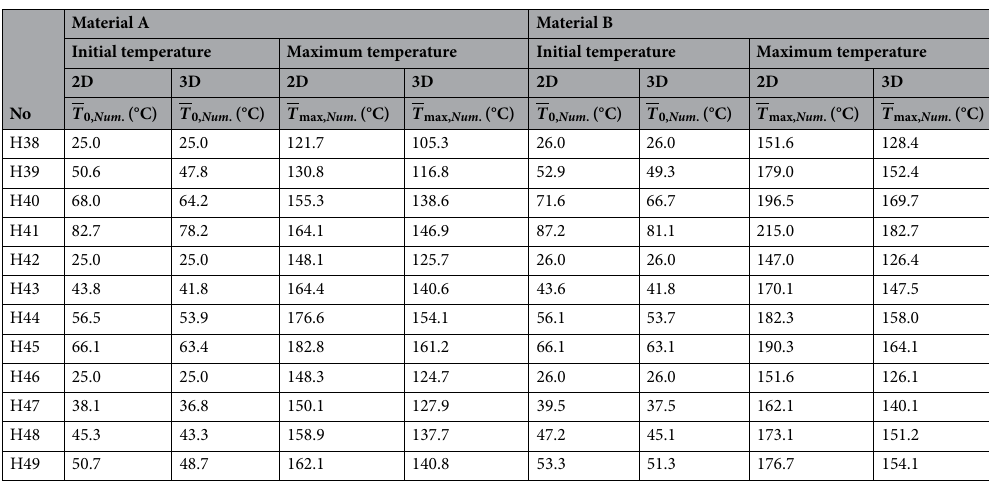
Table 10. Results of numerical calculations: initial temperature and maximum temperature on the contact surface during braking.